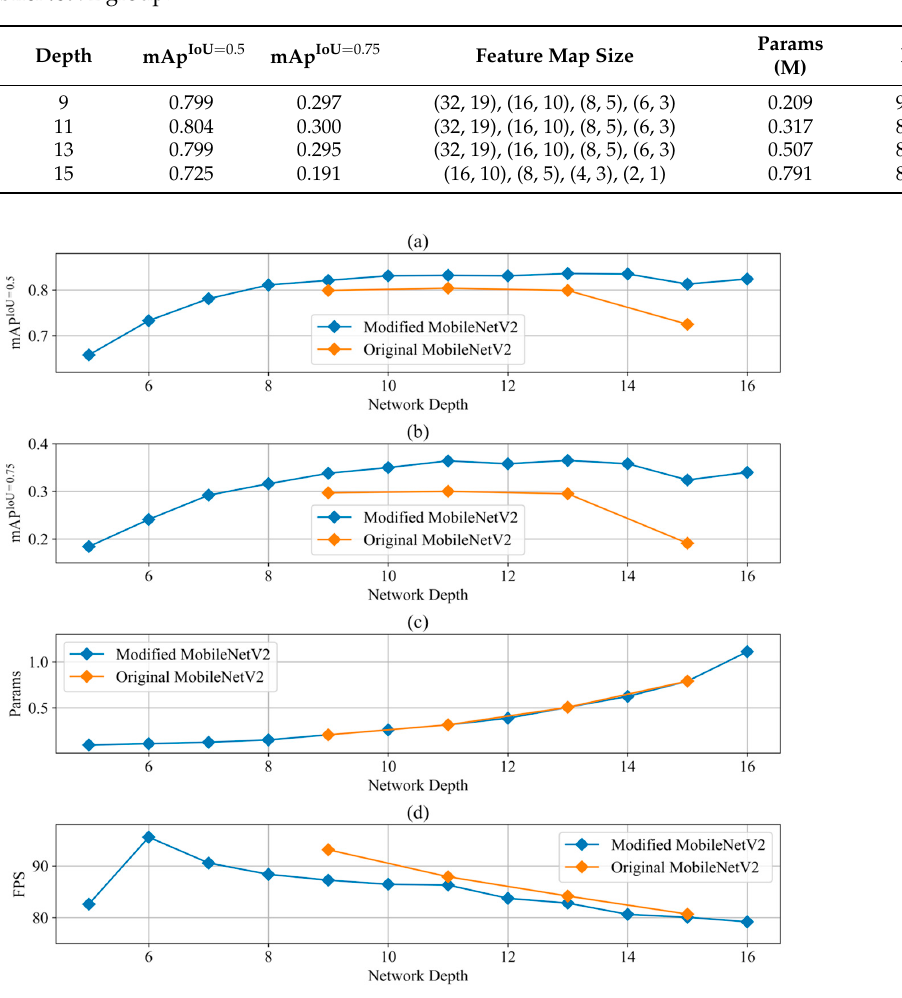
Table 7. Relationship between depth and Autofocus SSD prediction performance in Original Mo- bileNetV2 group.